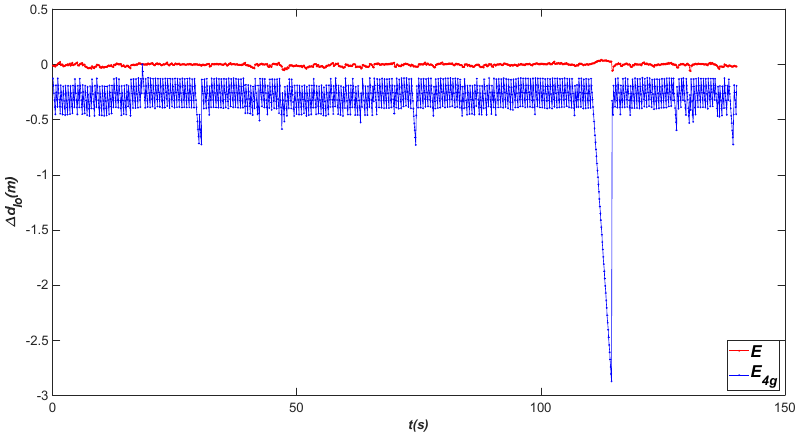
Figure 7. Schematic diagram of real-time E and E 4g.